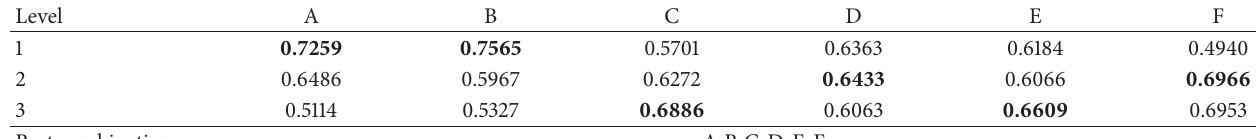
Table 6: Averaged closeness value over each level of control